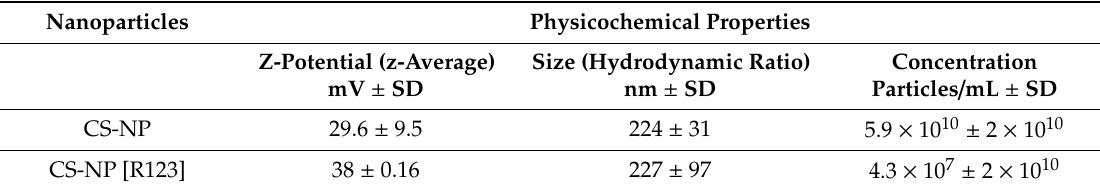
Table 1. Physicochemical properties of chitosan nanoparticles (CS-NP). The data corresponds to the average of five independent batches.